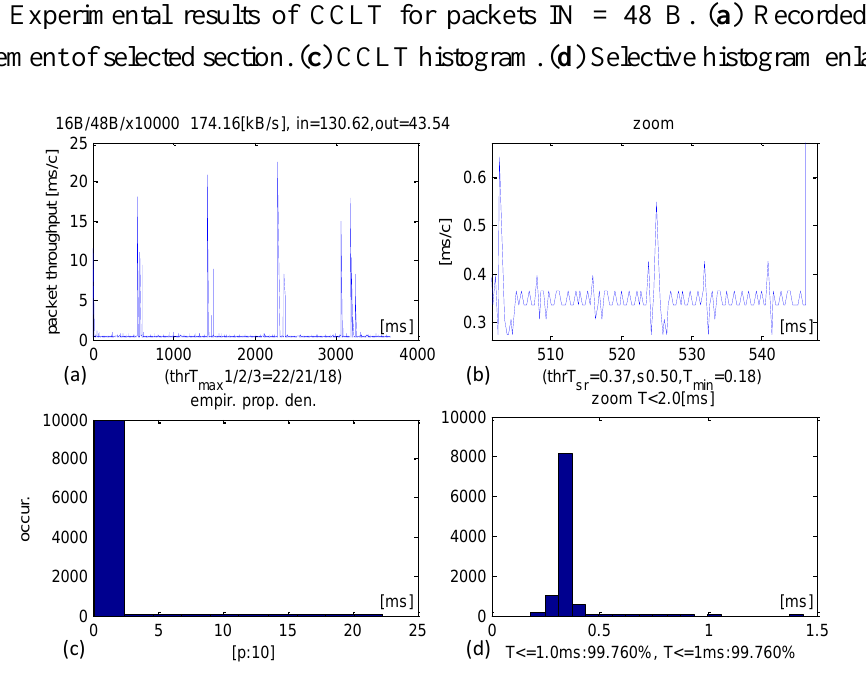
Figure 5. Experimental results of CCLT for packets IN = 200 B. ( a ) Recorded CCLTs. ( b ) Enlargement of selected section. ( c ) CCLT histogram. ( d ) Selective histogram